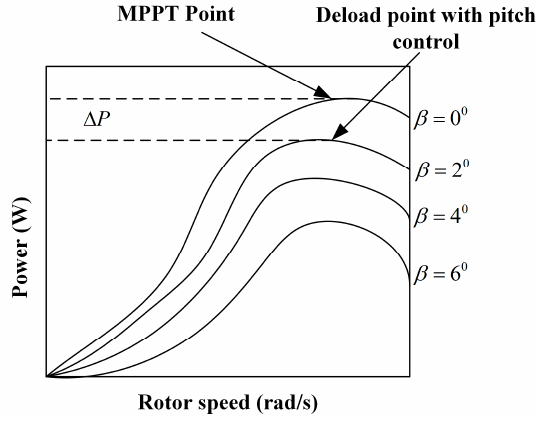
Figure 16. De-loaded curves with pitch angle control for wind turbine.